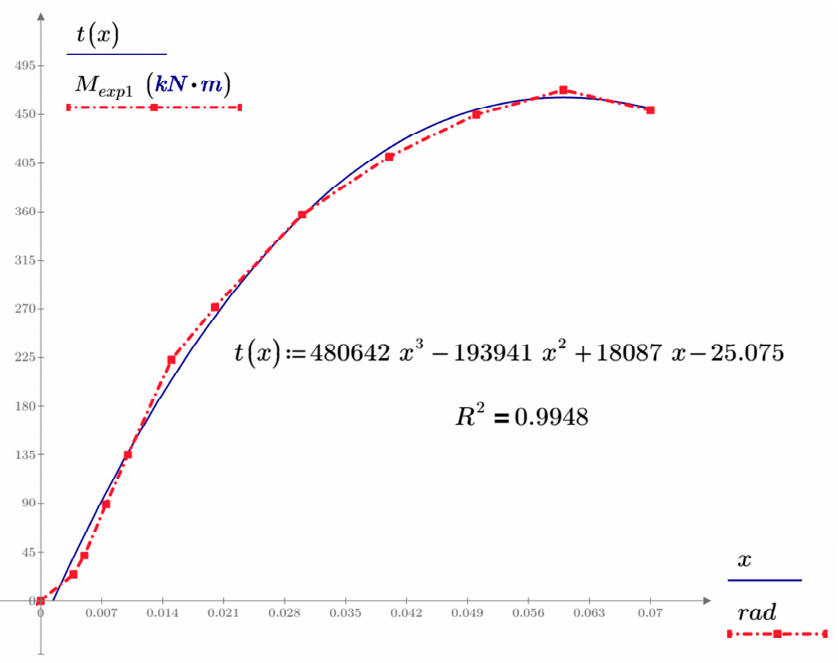
Figure 10. Experimental envelope of the momentum-rotation curve.